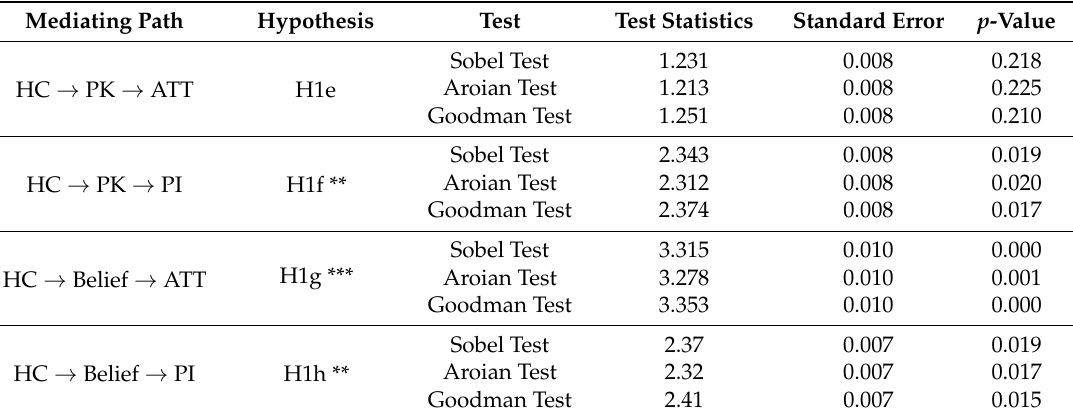
Table 7. Results of mediating